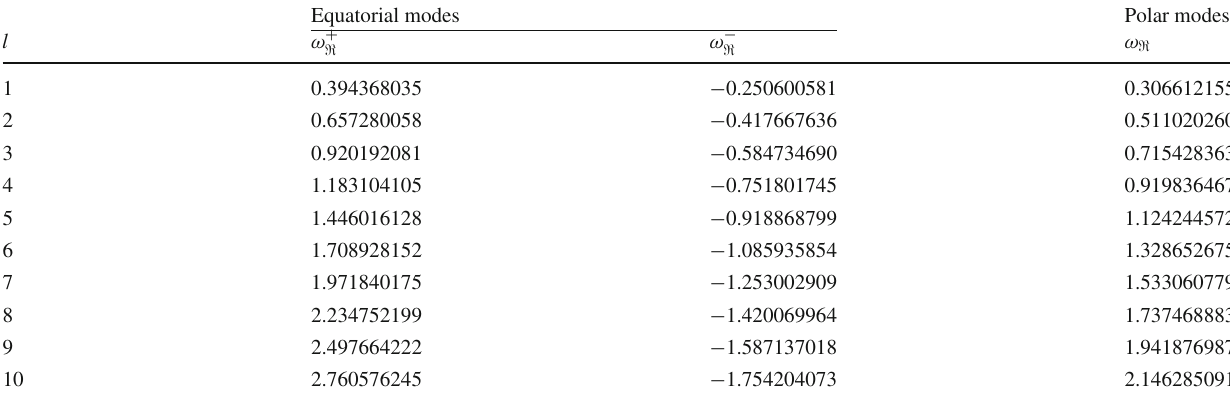
Table 2 Numerical values of the real part of QNMs for equatorial modes and polar modes. We have set M = 1 , Q / M = 0 . 5 , a / M = 0 . 5 ,γ = 0 . 001 ,ω q = − 2 / 3 and b = 0 .